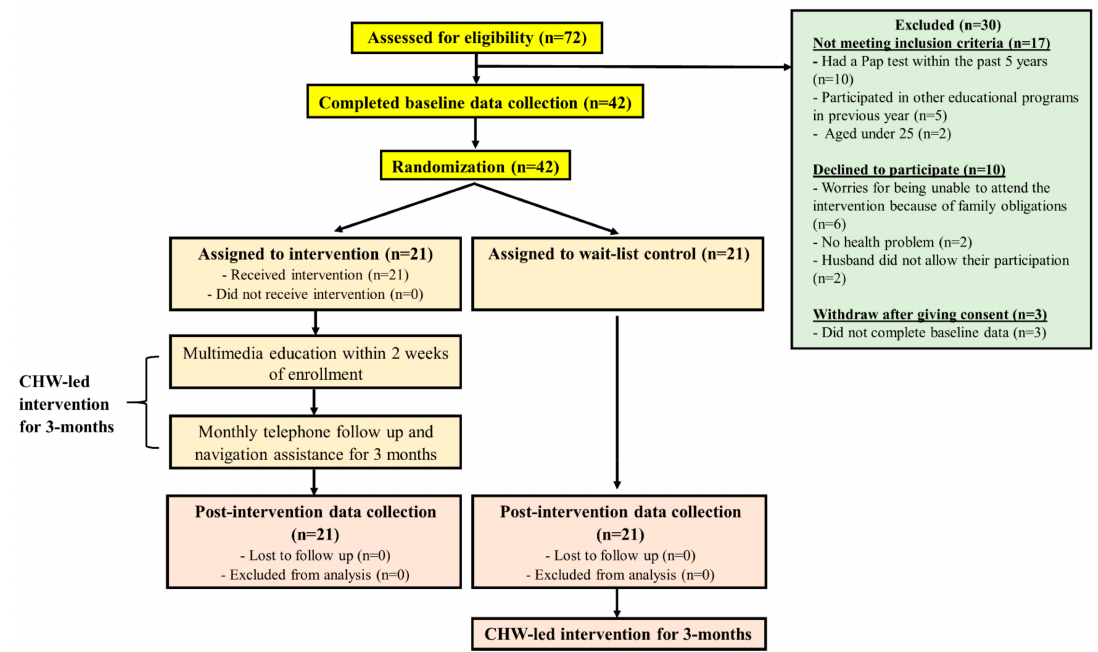
Figure 1. The flow diagram of intervention and data collection points. CHW: community health